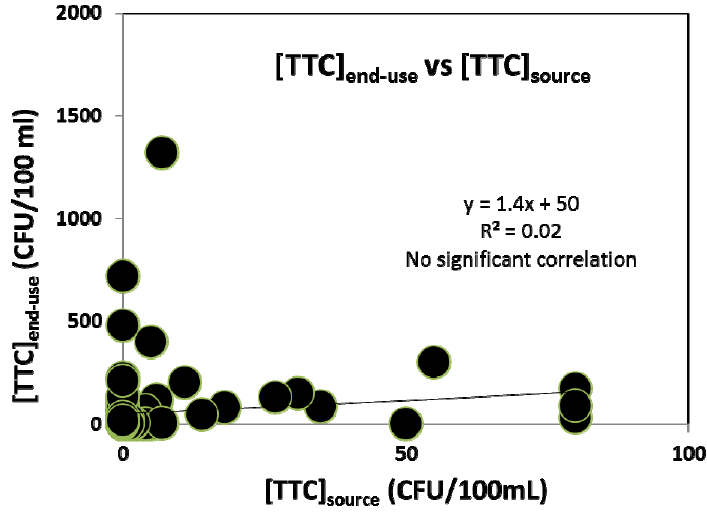
Figure 4. Cross-plot of arsenic and thermally tolerant coliforms in water supplied to households in the Chakdha, West Bengal, India study area through three different arsenic mitigation options. There is no significant correlation between [As] and [TTC] of Tap Water Supply ( ● ; R 2 = 0.034), Arsenic Treatment Plant ( ■ , R 2 = − 0.002), Deep Tube Wells ( ▲ , R 2 = 0.064) of for the dataset as a whole (R 2 = 0.003). R 2 refers to the correlation for the simple least squares linear regression between [As] and [TTC] the relevant